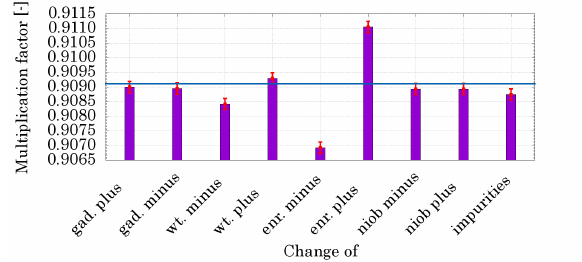
Figure 14. Effect of material uncertainties on multi- plication factor